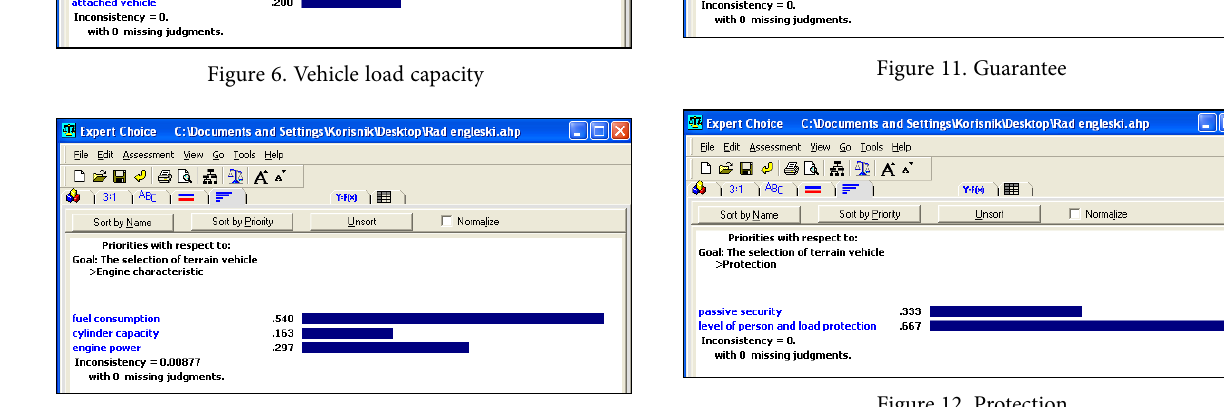
Figure 7. Engine characteristics